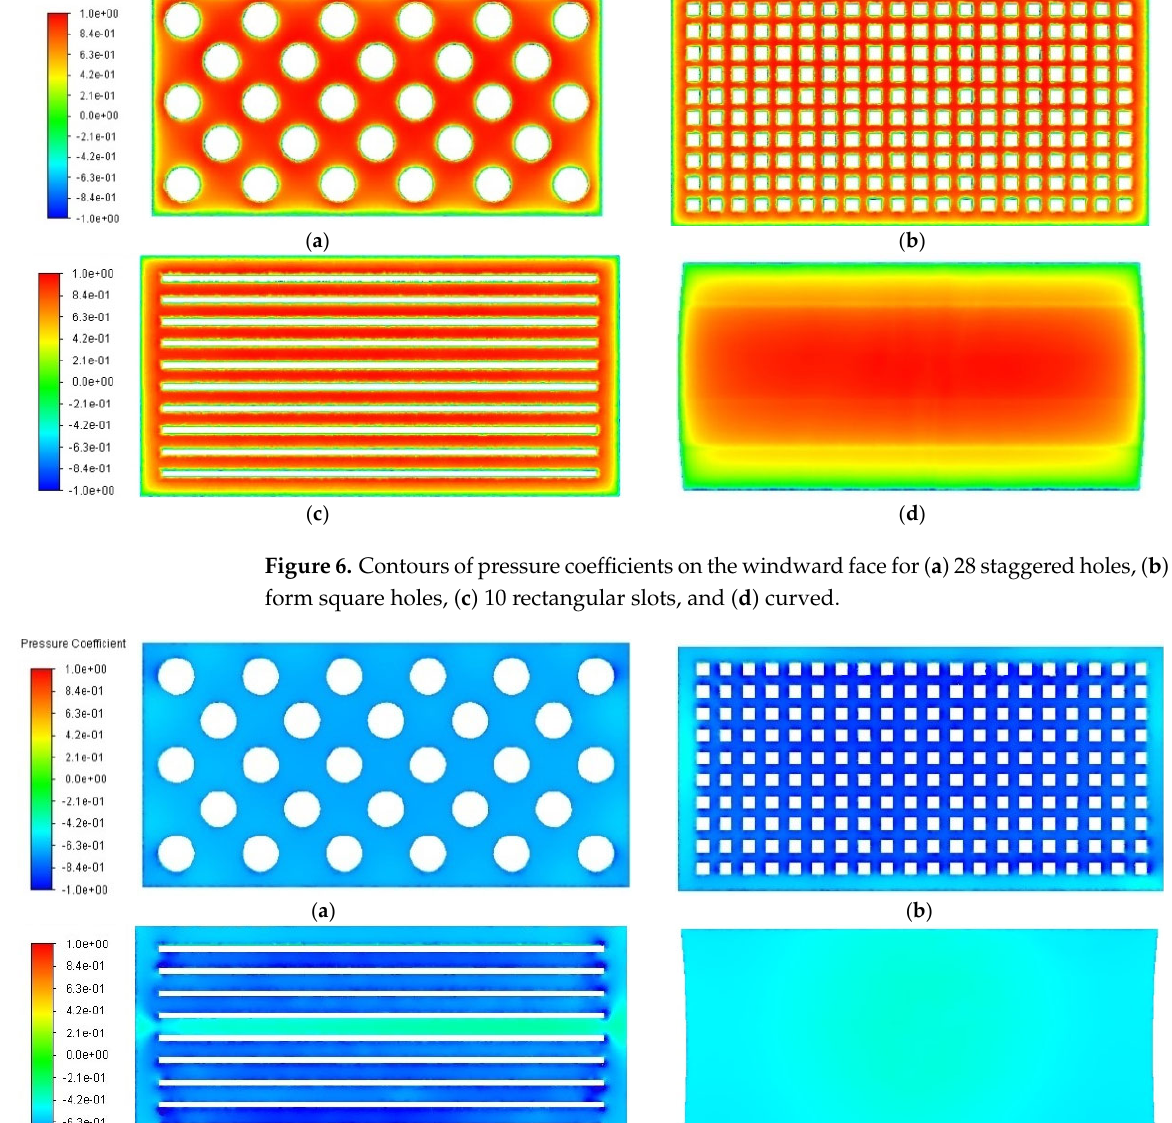
Figure 5. Pressure coefficients contour on the standard panel: ( a ) windward face, ( b ) side view, ( c ) leeward face, and ( d ) top view.